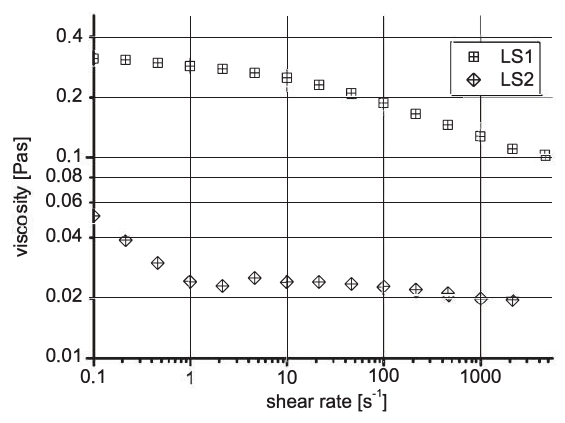
Figure 4. The viscosities of printing inks LS1 and LS2 versus shear